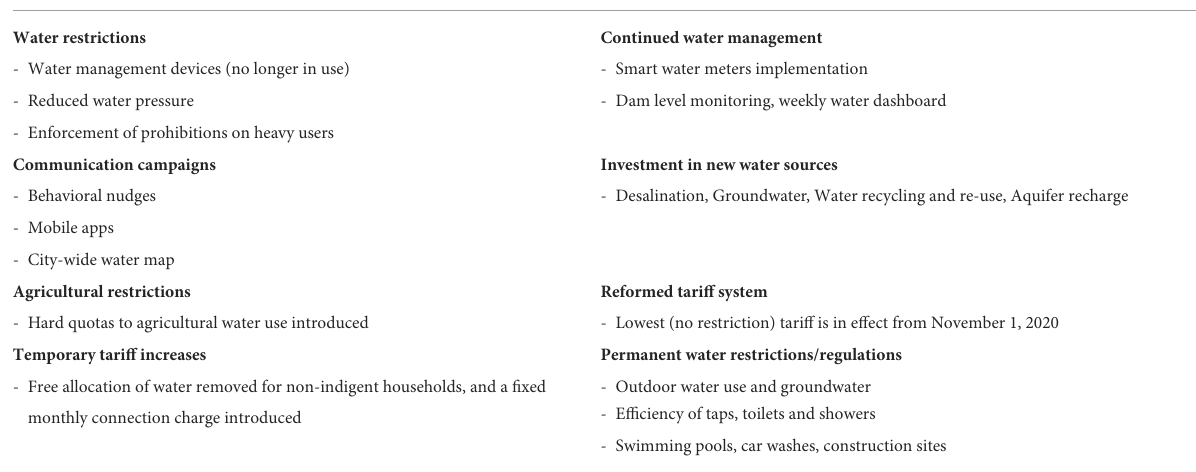
TABLE 4 City of Cape Town measures put into place in 2017/2018 to avoid “Day